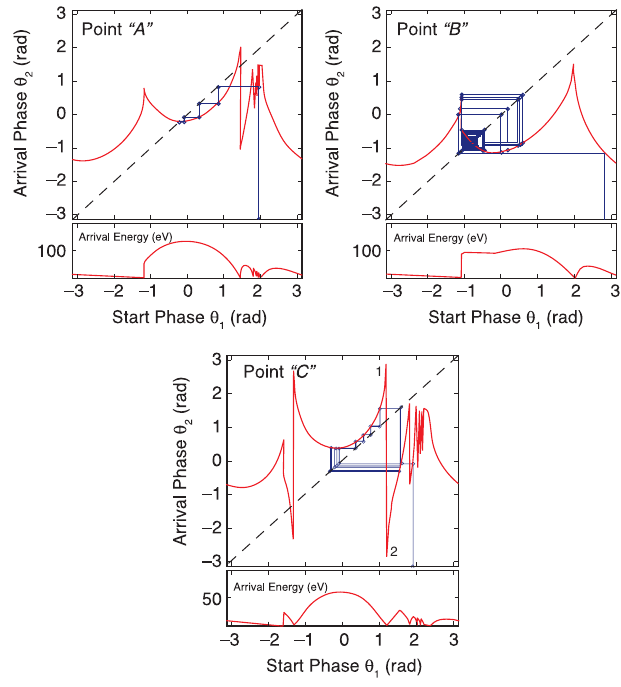
FIG. 5. Starting and arrival phases, and impact energy at arrival for the marked points of Fig. 1.